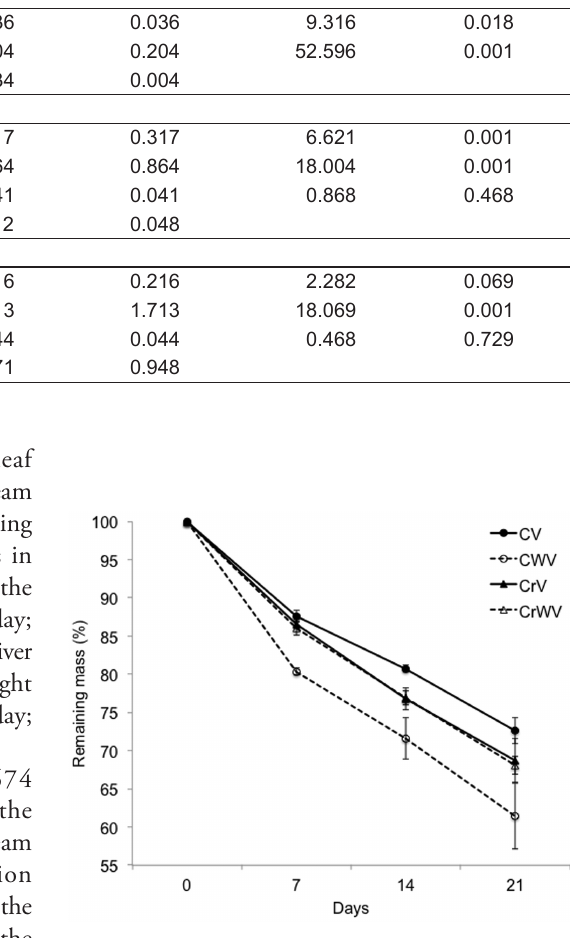
Figure 2. Remaining mass (± SE) of Campomanesia xanthocarpa leaf litter in the streams in the Campo river hydrographic basin and Cravo river hydrographic basin, Southern